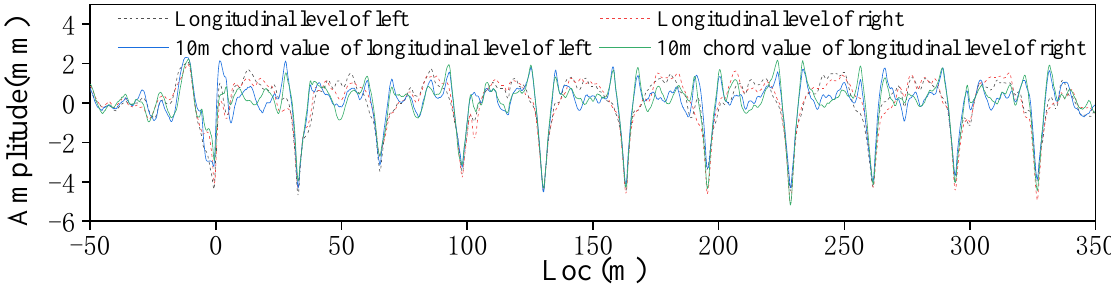
Figure 14. Track longitudinal level and 10-meter chord measurement in bridge section.